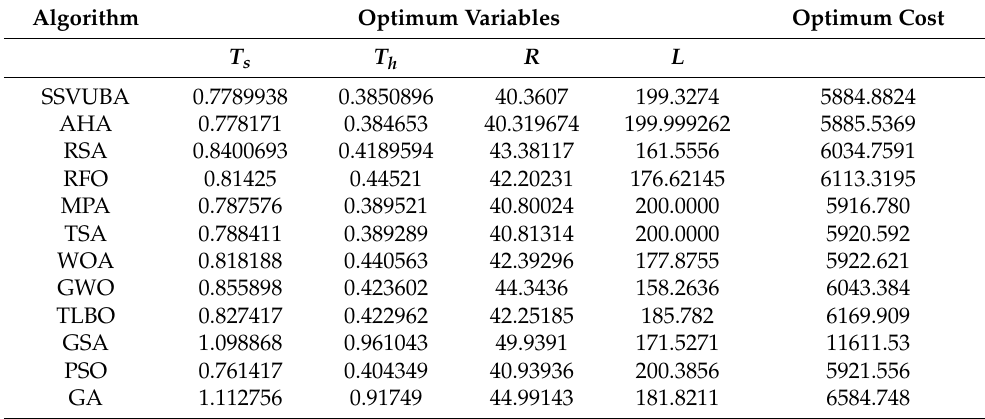
Table 10. Performance of optimization algorithms in the pressure vessel design problem.